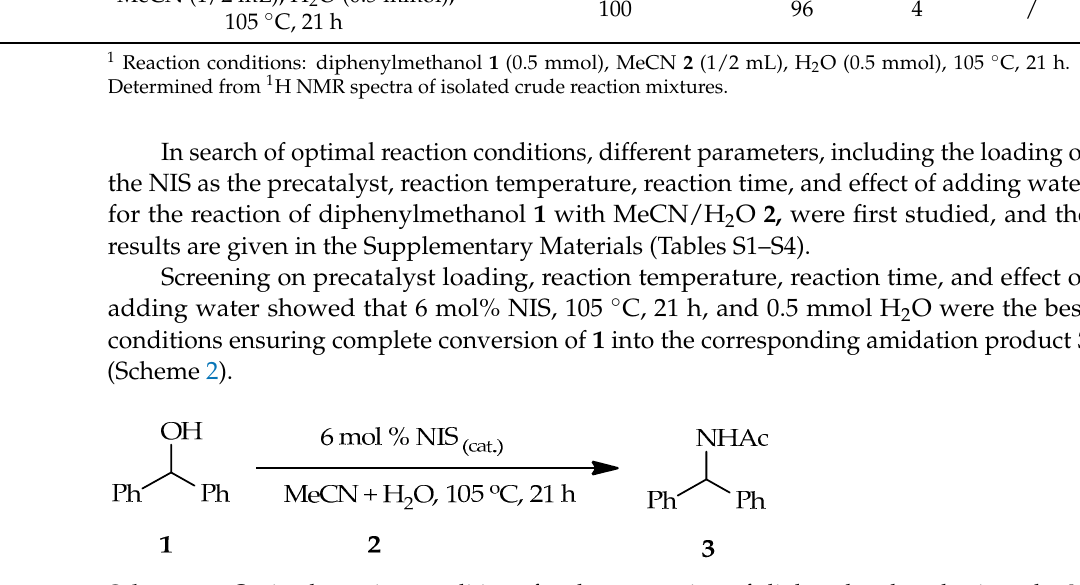
Scheme 2. Optimal reaction conditions for the conversion of diphenylmethanol 1 into the N - benzhydrylacetamide 3 mediated by